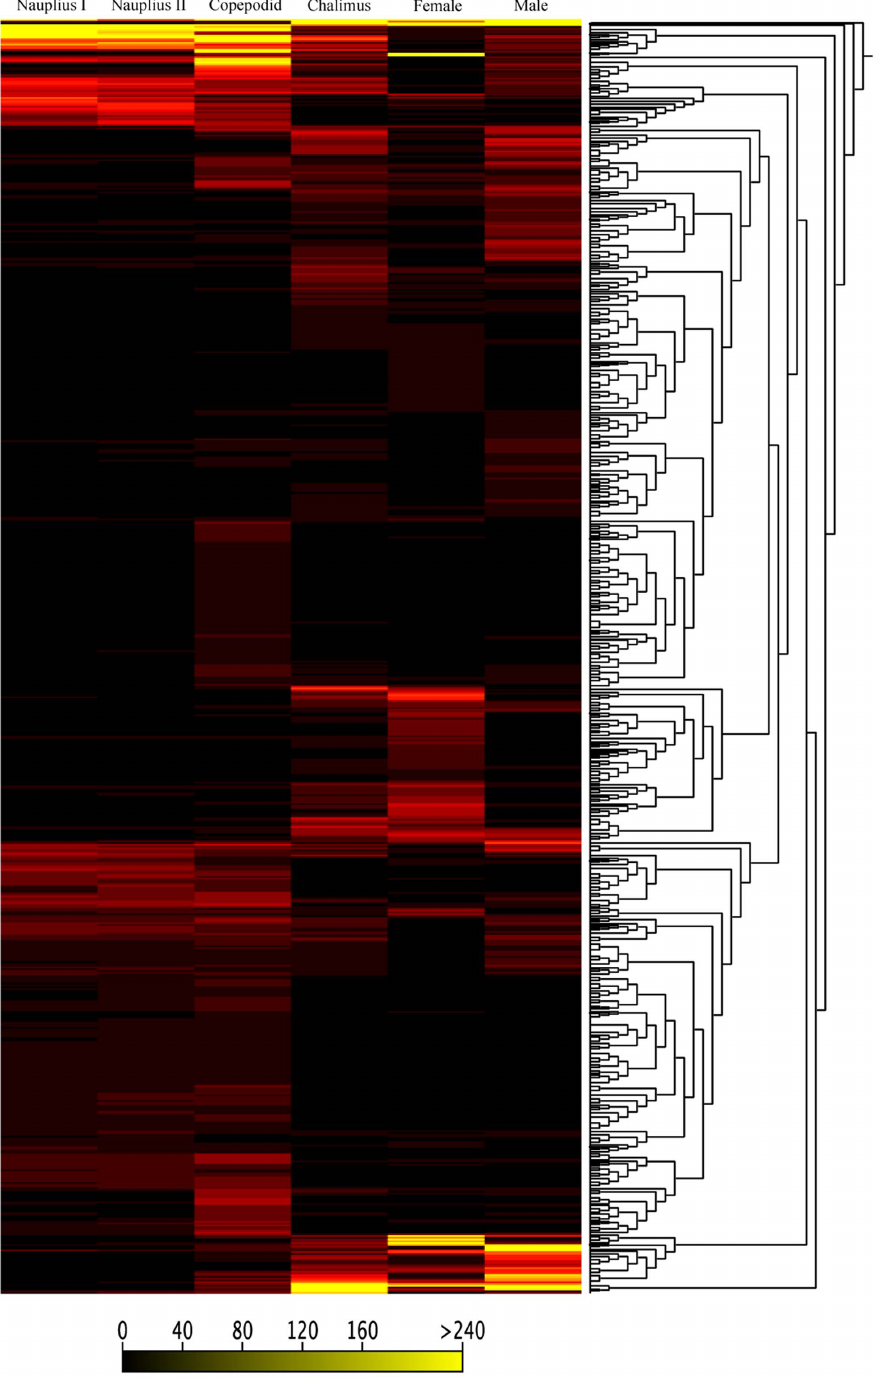
Figure 3. Heat map generated from C.rogercresseyi transcriptome data reflecting gene expression values in six developmental stages. Dendrograms of the transcription patterns were estimated for 83,444 contigs generated by de novo assembling. The bar color reflects the gene expression levels.